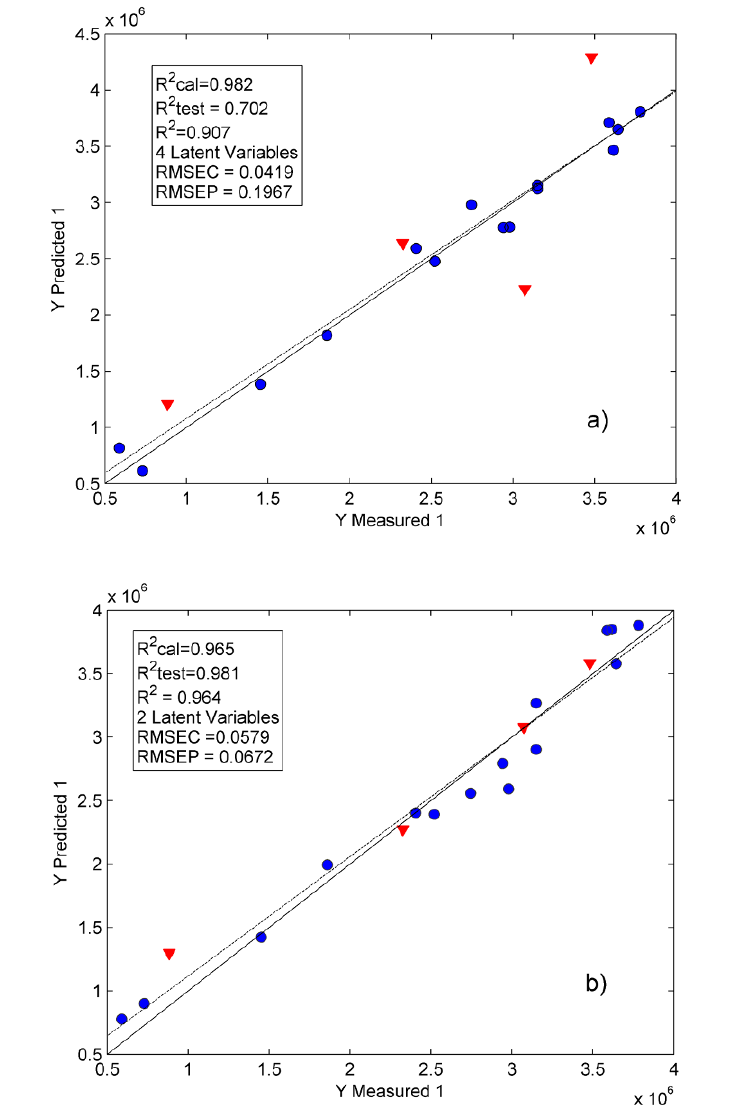
Figure 5. Plot of cross-validate predicted versus measured lovastatin relative amount for the SNV+OSC corrected data set, a) global model, b) local model after UVE-PLS application. Dots are for the samples used in calibration, triangles for those in prediction stage. Inserts give the performance